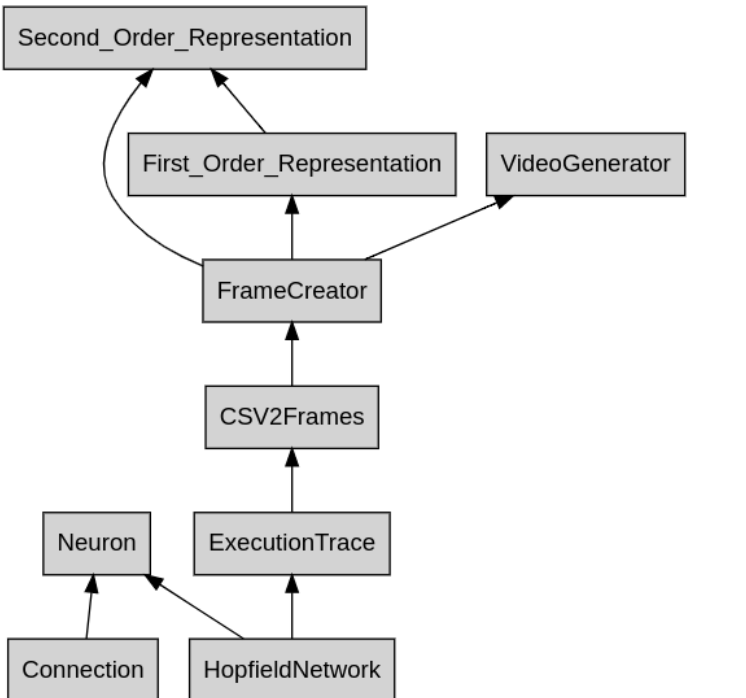
Figure 5. Diagram about the relations between the different concepts and their relations. Arrows represent relation between classes.